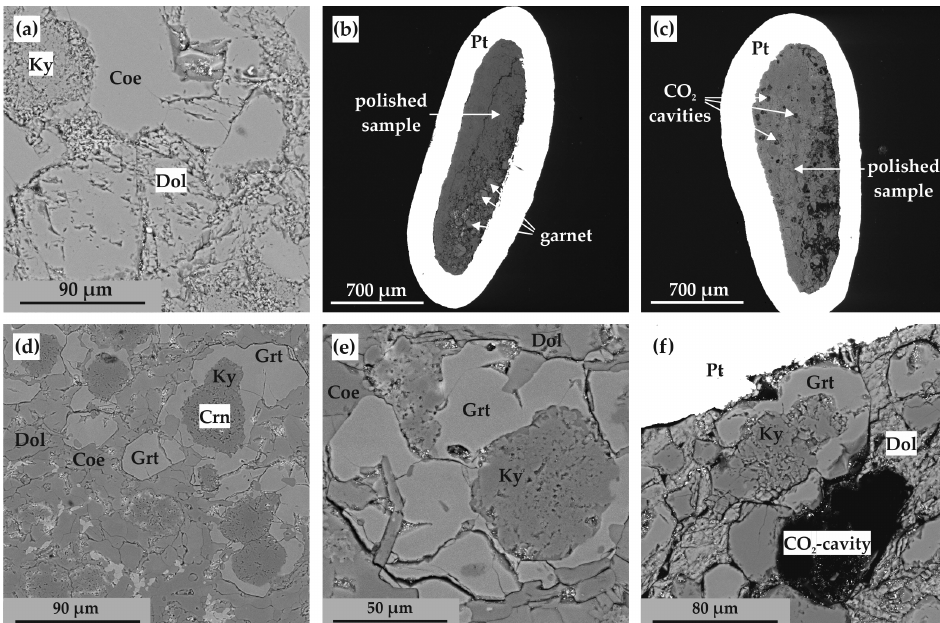
Figure 10. SEM micrographs (backscattered electrons (BSE) regime) of polished sample fragments (CaMg(CO 3 ) 2 -SiO 2 -Al 2 O 3 system): ( a ) polycrystalline aggregate of dolomite, coesite and kyanite (N